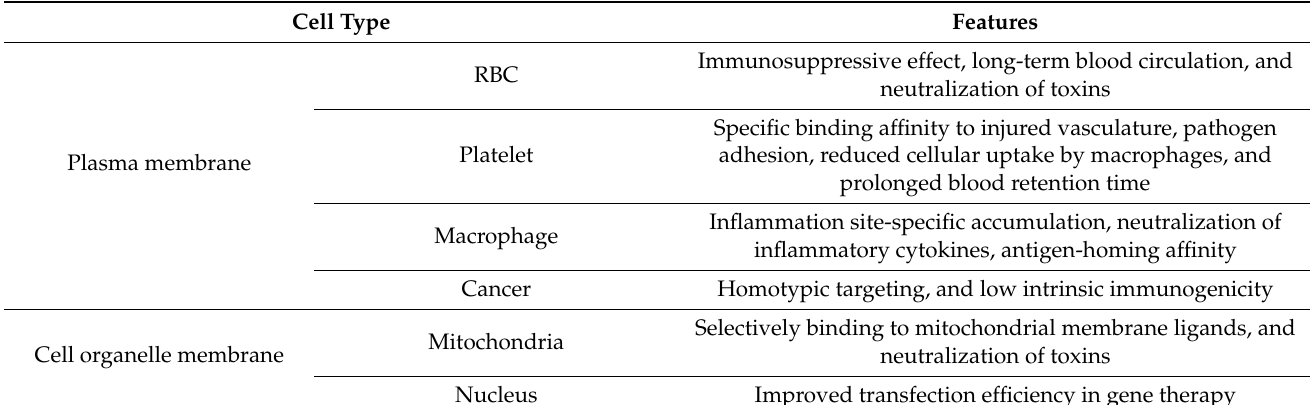
Table 1. Unique features of natural cell